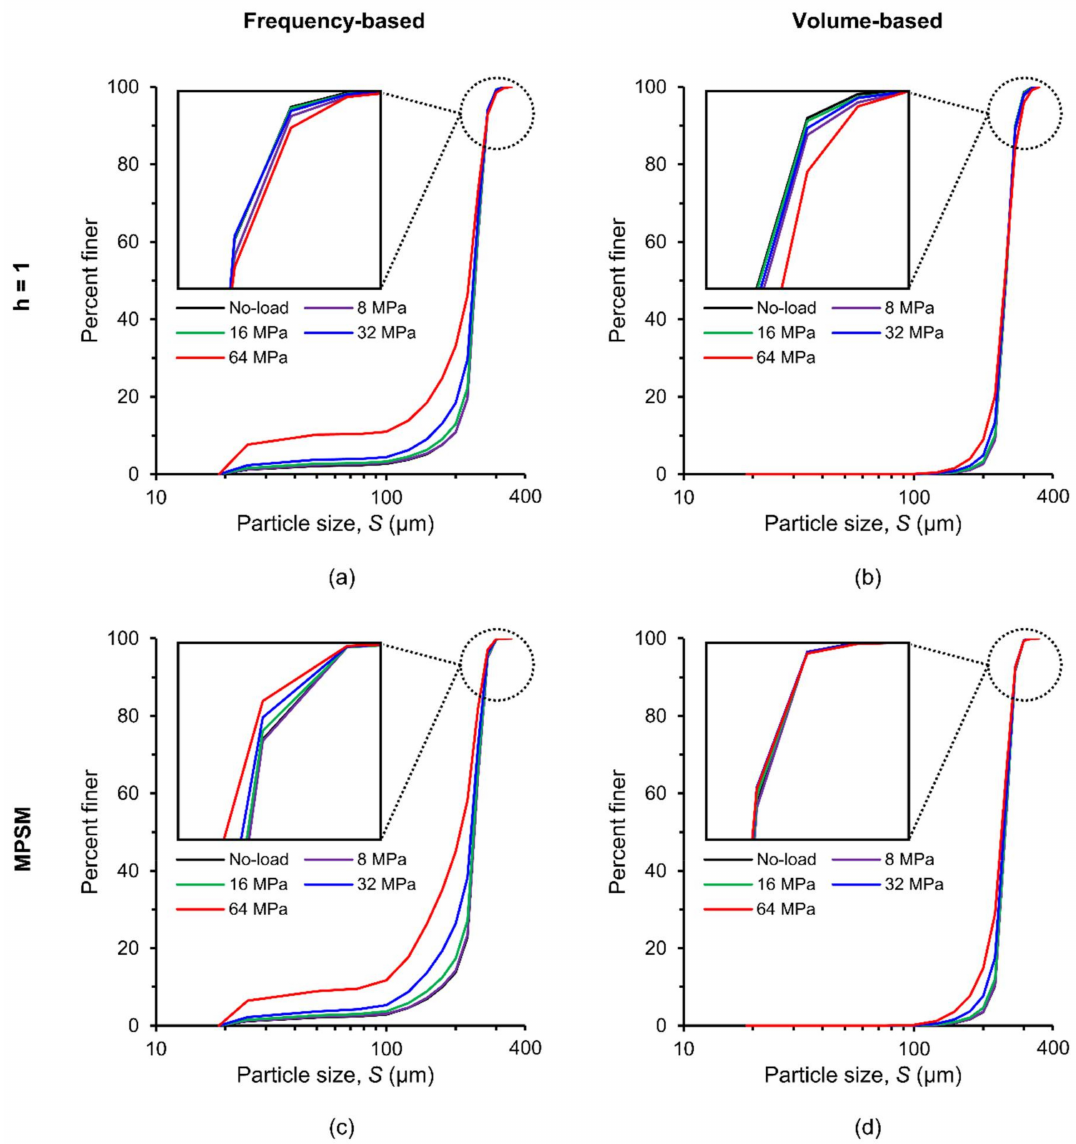
Figure 8. Particle size distributions of RBS particles at different vertical stresses based on: ( a , b ) the routine watershed separation method, ( c , d ) the Monash Particle Separation Method